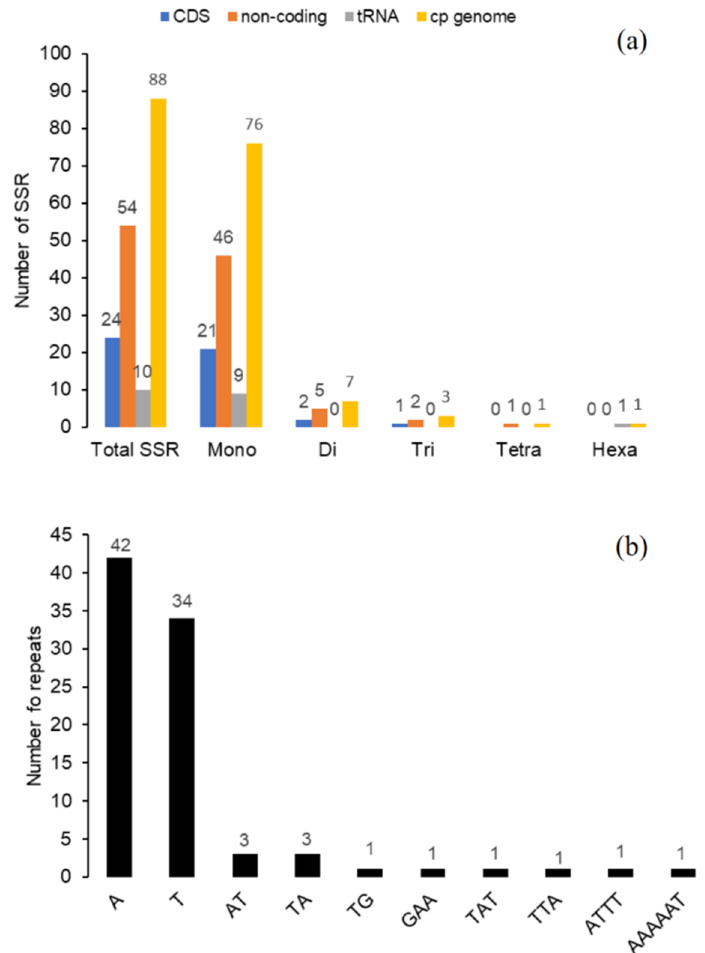
Figure 7. Analysis of simple sequence repeats (SSRs) in A. spinosa cp genome. ( a ) Number of SSR types in the cp complete genome, coding, and non-coding regions; ( b ) Number and type of SSR motifs identified in the cp genome. CDS, coding domain sequences.